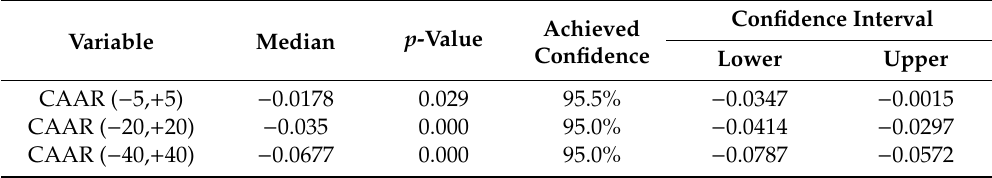
Table 6. Wilcoxon test on CAAR.